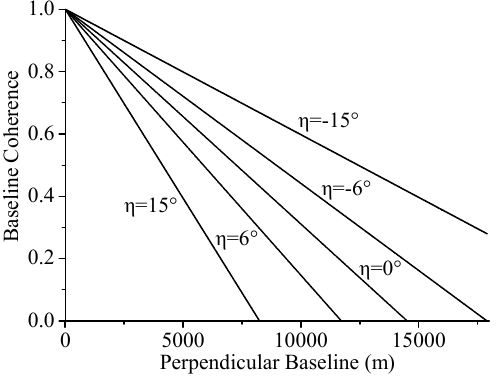
Figure 2. Baseline coherence versus the perpendicular baseline and terrain slope.